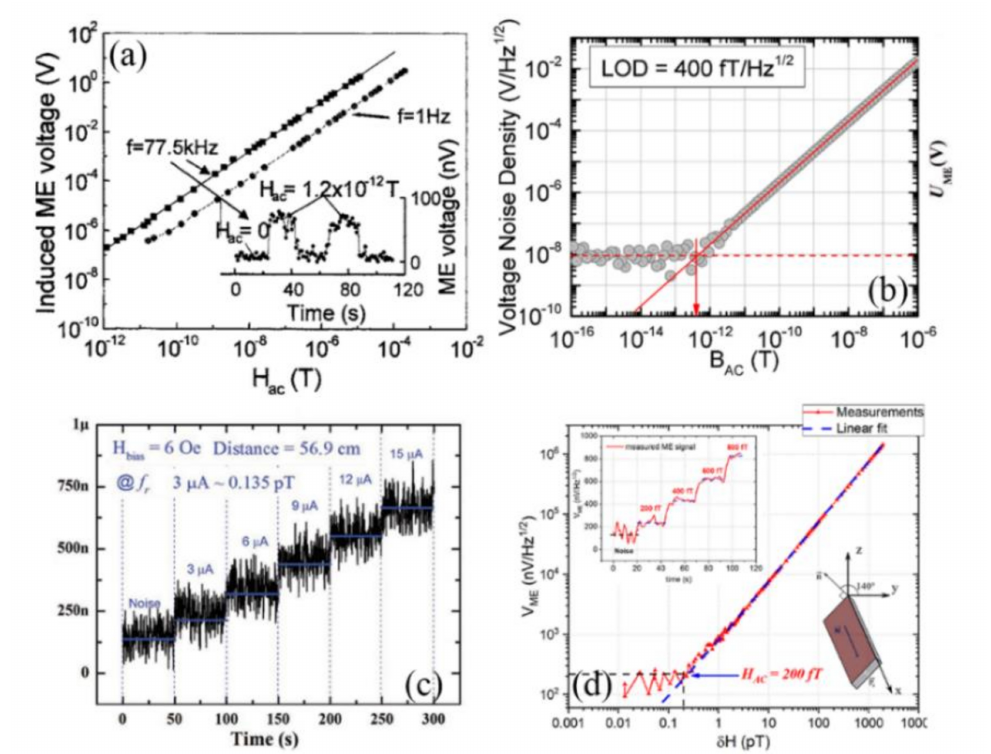
Figure 6. ( a ) Magnetic field detection limit measurements at frequencies of f = 1 Hz and f = 77.5 kHz (resonance condition), respectively [29]; ( b )The measurement of LOD for MEMS ME sensor [47], ( c ) for 1-1 typed ME sensor [8] and ( d ) for a 2-2 ME bimorph